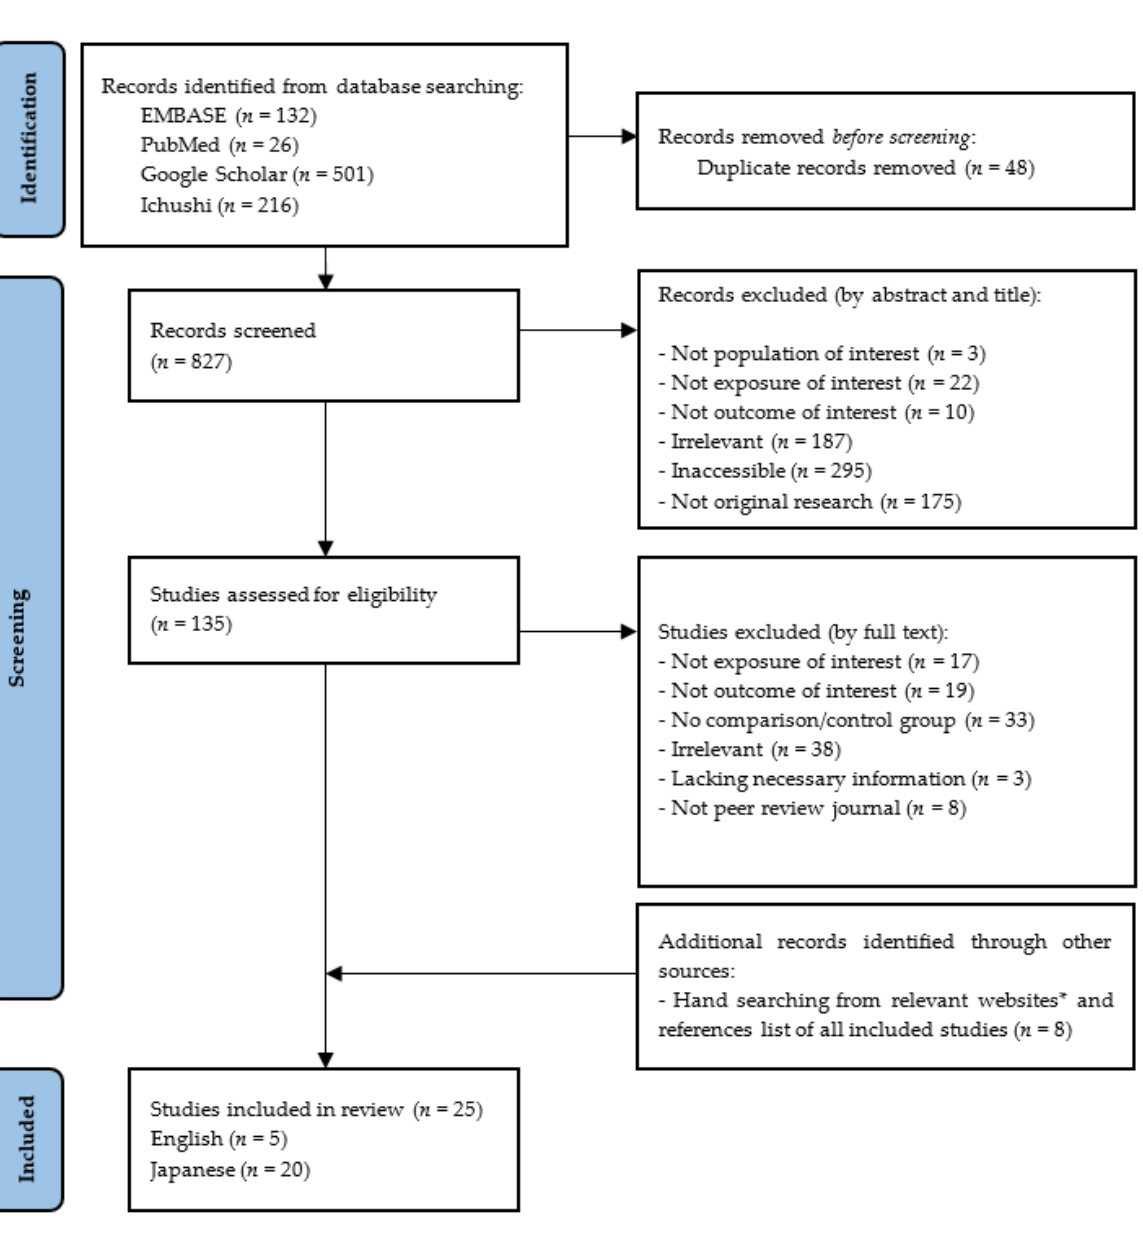
Figure 1. * List of websites: 8020 Promotion Foundation; Japanese Society for Oral Health (JSOH); Ministry of Health, Labour, and Welfare (MHLW). Table 1. The result of quality assessment.